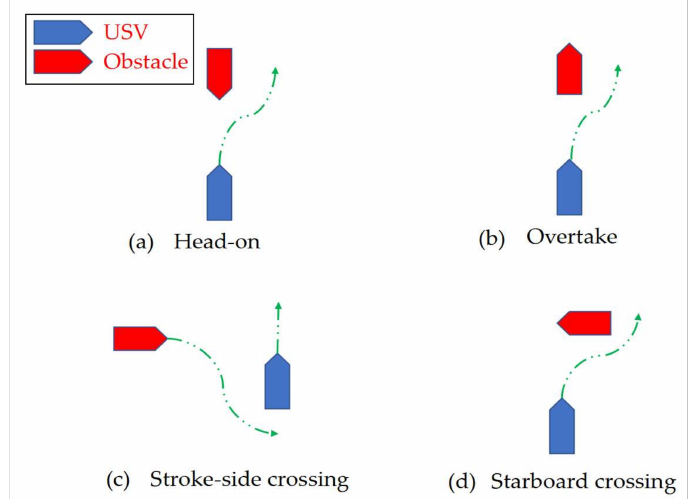
Figure 4. COLREGs rule selection for collision avoidance under different encounter